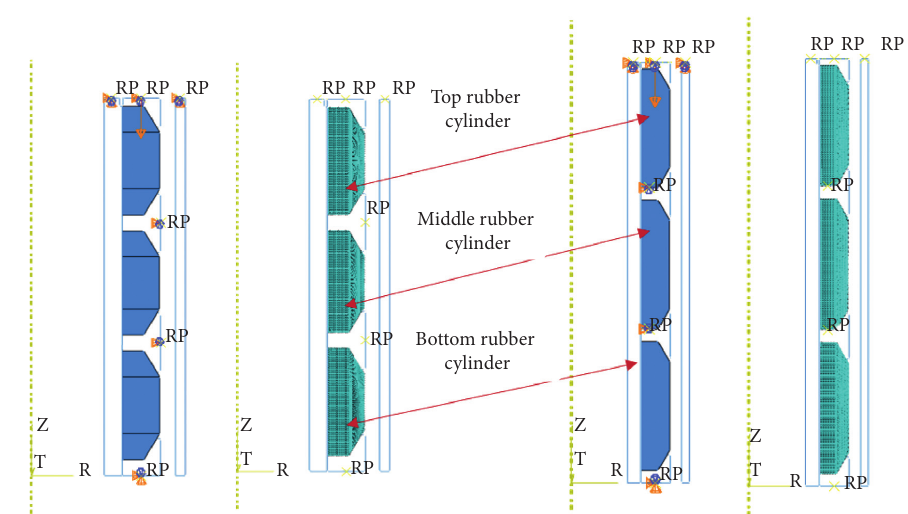
Figure 8: Rubber cylinders and finite element models.